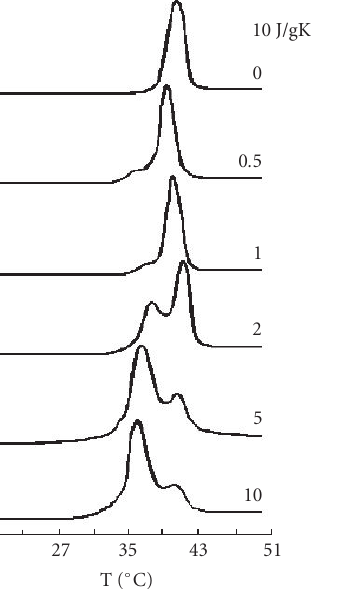
Figure 1: Heat denaturation peaks of irradiated collagen: the num- bers in the picture indicate duration of the irradiation in minutes. In each experiment protein concentration in solution is 0 . 6 mg/ml, pH 3 . 7.